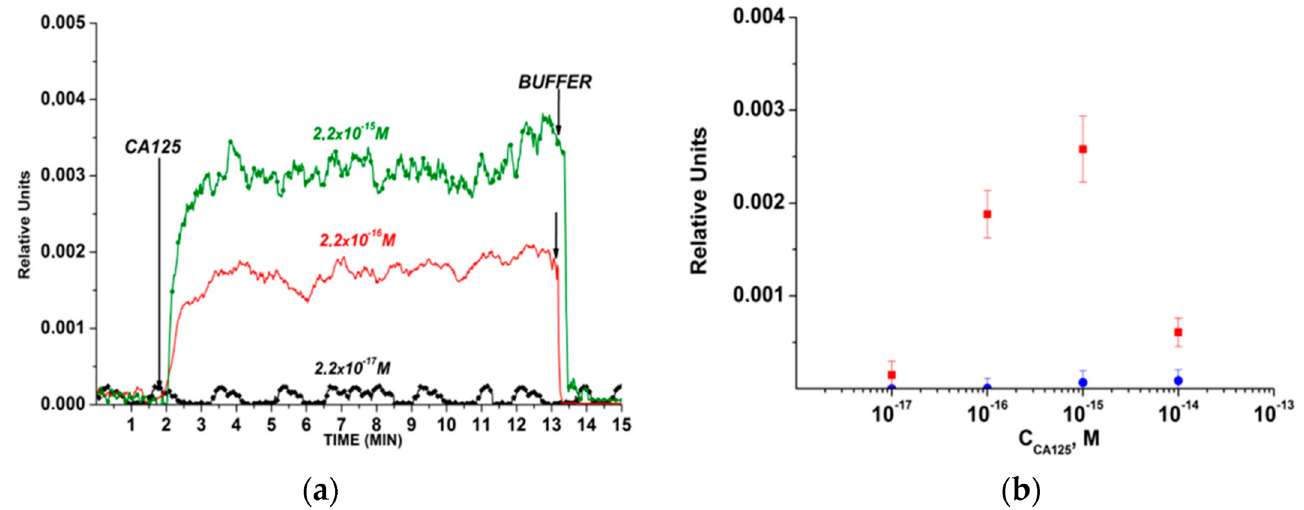
Figure 2. The outcomes acquired from the detection of CA-125 protein in buffer solution while employing a silicon-on-insulator (SOI) nanowire biosensor with covalently immobilized antibodies: ( a ) common sensorgrams acquired upon assessment of solutions with diverse concentrations of the target protein; ( b ) dependencies of the level of the biosensor signal on the concentration of CA-125 in buffer solution [76].